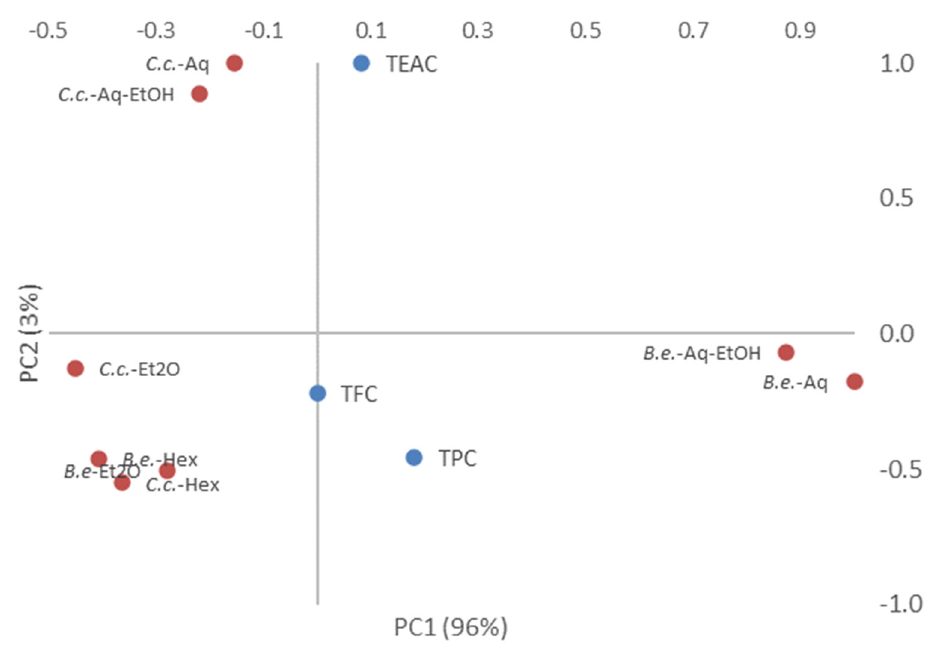
Figure 1. PCA biplot of mushroom extracts based on their TPC, TFC, and TEAC. B.e. - Boletus edulis ; C.c. - Cantharellus cibarius ; Aq-aqueous extract; Aq-EtOH-hydro-alcoholic extract; Hex-hexanic extract; Et2O-etheric extract; TPC-total phenolic content; TFC-total flavonoid content; TEAC-Trolox equivalent antioxidant capacity.